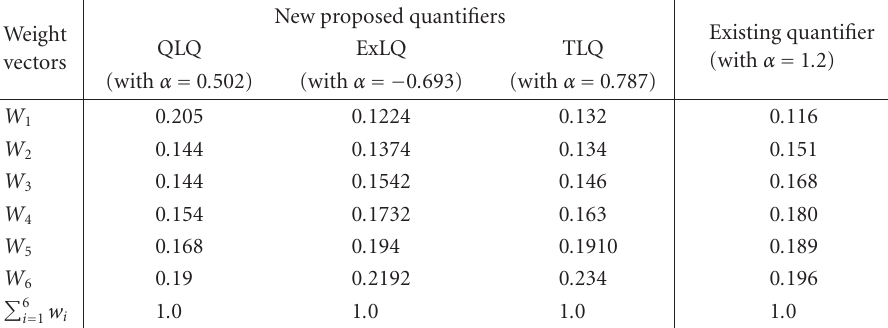
Table 4.2. Weight vectors for di ff erent quantifiers.